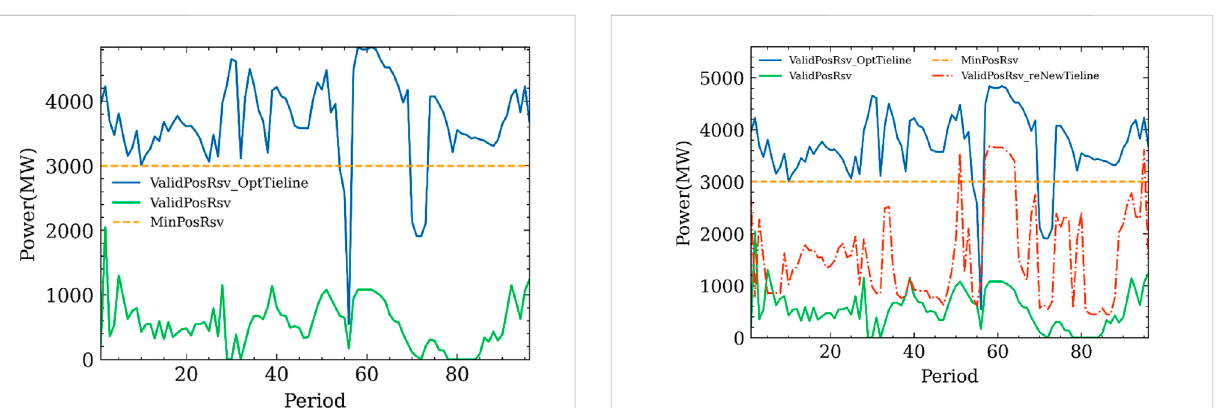
FIGURE 8 Comparison diagram of the effective positive